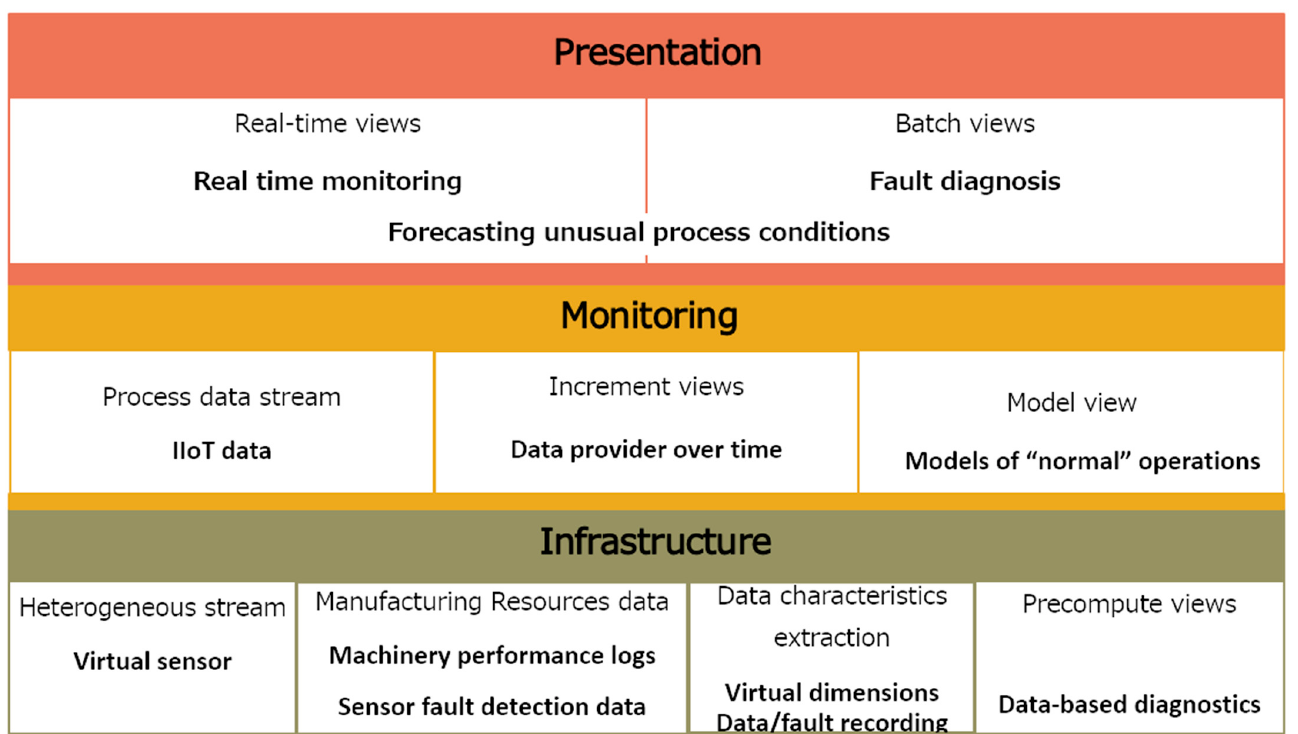
Table 3. Requirements of fault diagnosis scenarios.